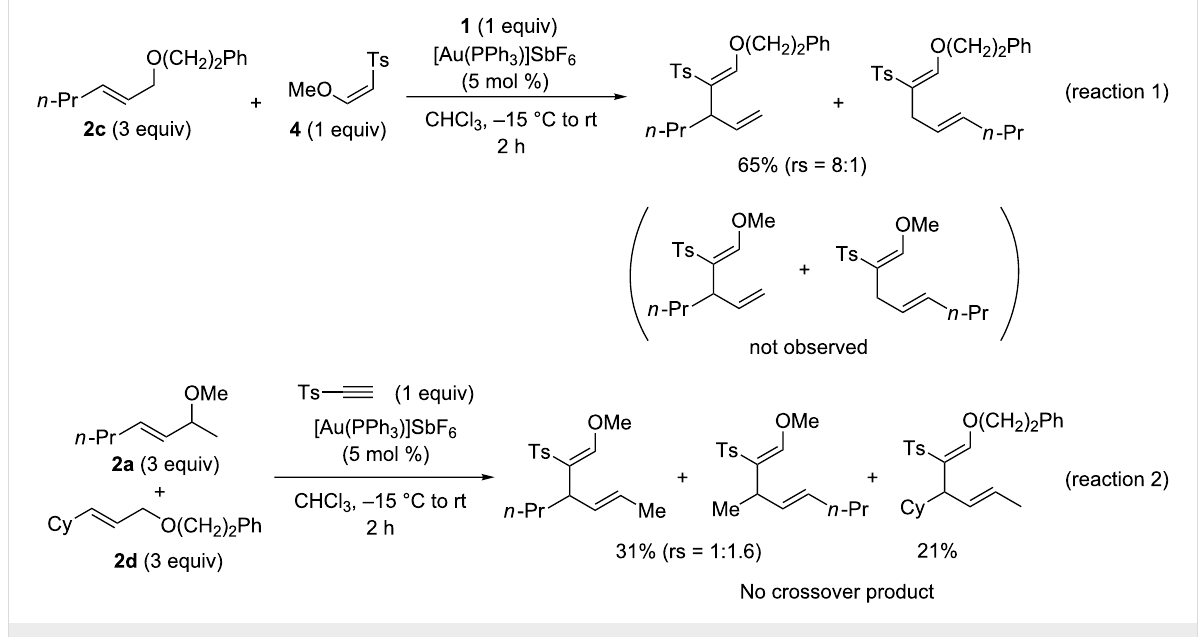
Scheme 2: Experiments to investigate the reaction